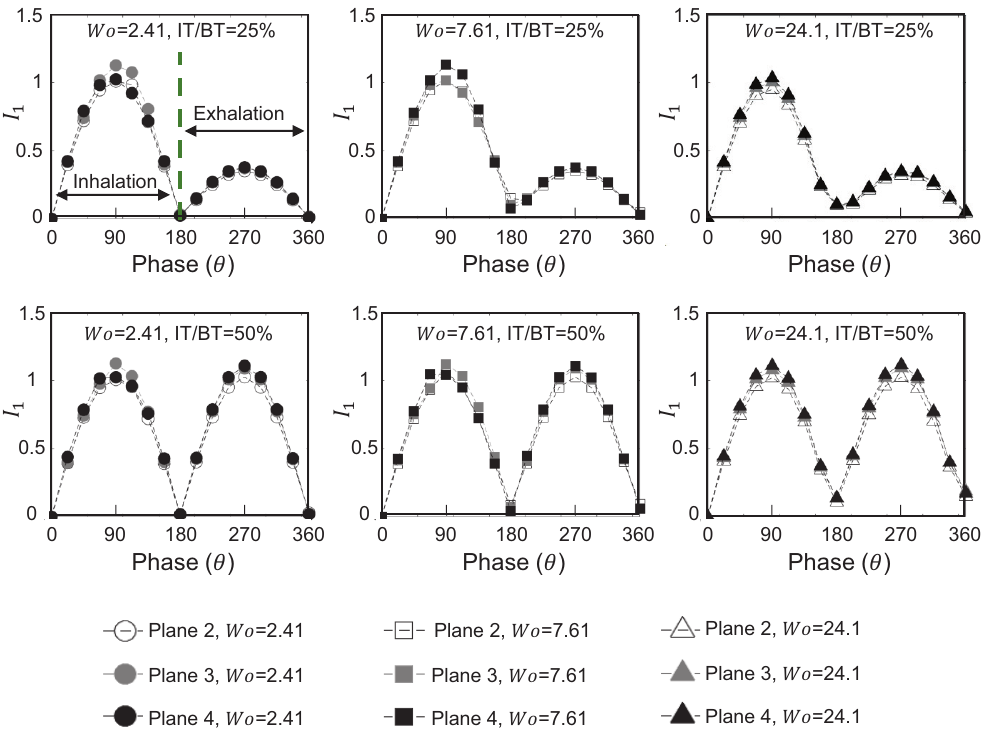
Figure 12. Integral parameter I 1 calculated using Equations (8) at Planes 2–4 for all breathing conditions at IT/BT = 25% ( top row ) and IT/BT = 50% ( bottom row ). Wo = 2.41 (- - - -); Wo = 7.61 (- - (cid:4) - -); Wo = 24.1 (- - (cid:78) - -). Open, gray-filled, and (cid:32) black-filled markers correspond to Planes 2, 3 and 4,